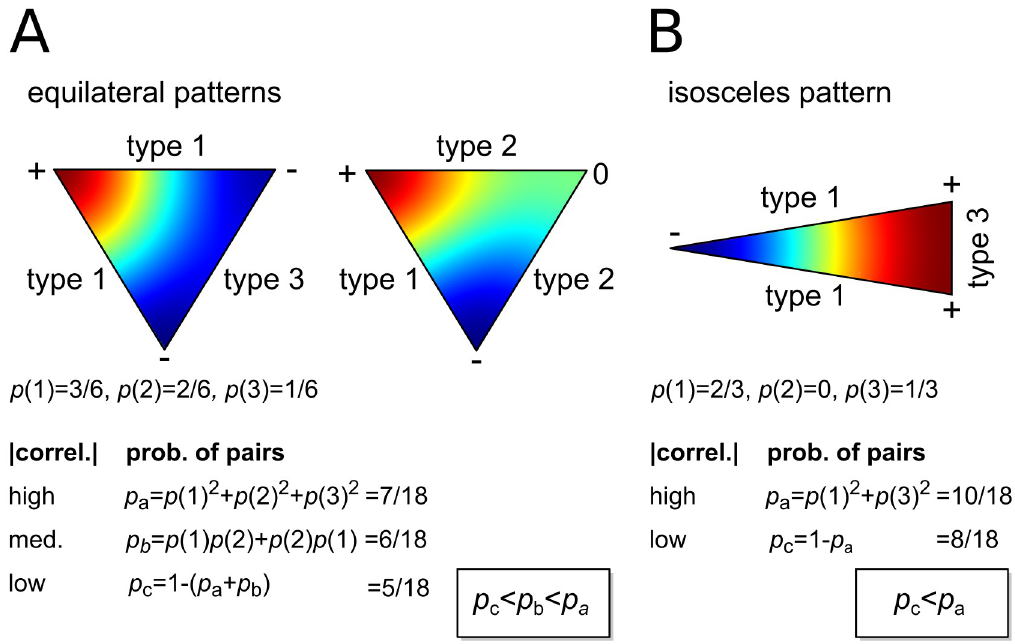
Fig 2. The distribution of pattern correlations along common edges of tessellating triangles should be bimodal. Colour images show typical patterns generated by a reaction-diffusion model with a large diffusivity term, using a colour map in which red and blue mark extreme high and low concentration values, and green marks zero concentration. A Solved within the boundary of an equilateral triangle, two basic patterns emerge, with extreme concentrations in one corner and along the opposite edge (left) or at two corners (right). Along the edges, three pattern types are apparent. Type 1 varies between the two extremes, type 2 varies between one extreme and zero, and type 3 does not vary. The probability of type i is given below as p ( i